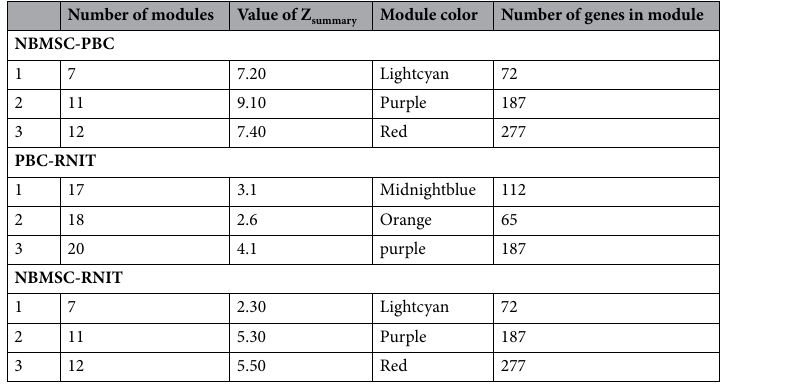
Table 1. Extracted modules and their properties at three